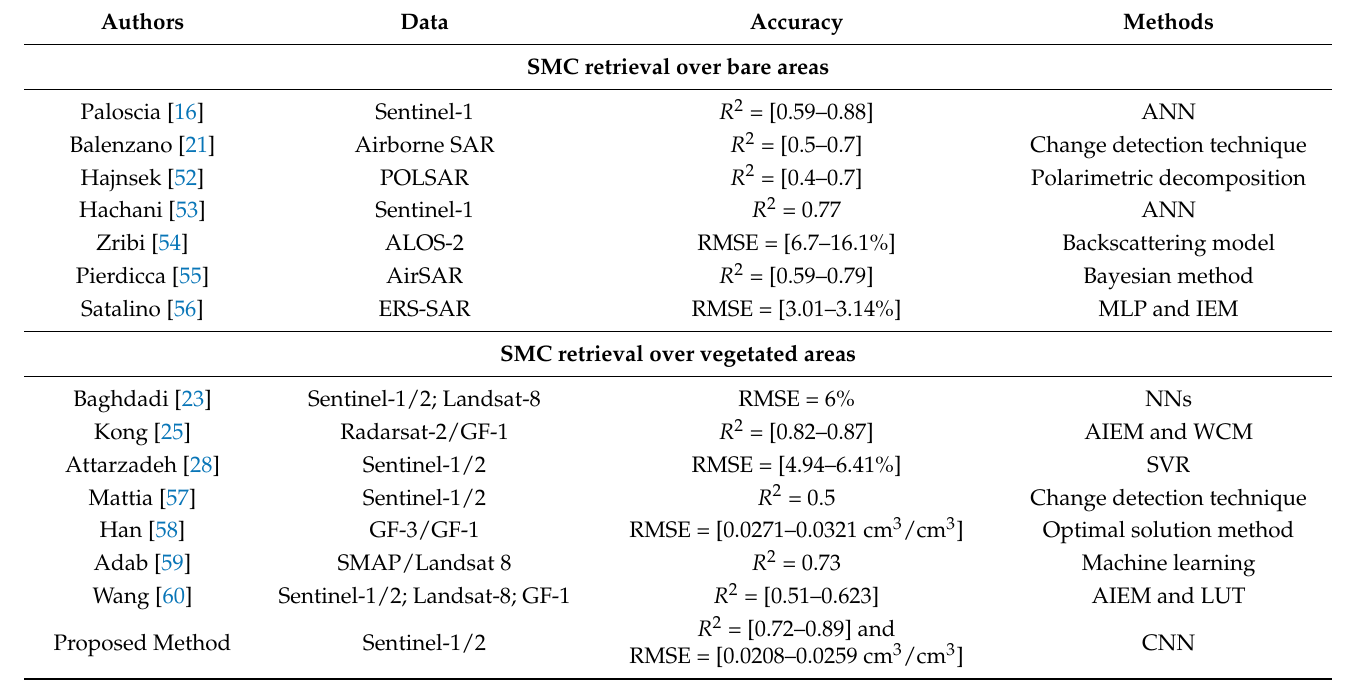
Table 5. Comparison of different approaches for estimating